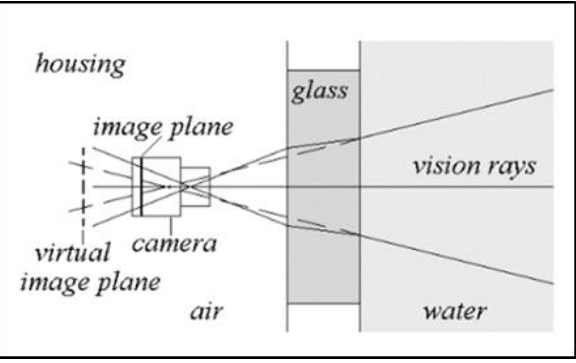
Figure 1. Multimedia Photogrammetry (Bräuer-Burchardt et al, 2016) For all the above reasons underwater images are characterized by non-uniform lighting, low contrast, little color variations and blur colors that affect their quality. In Underwater Photogrammetric applications, radiometric enhancement of the images should be considered as an important pre-processing stage. Before their use for 3D